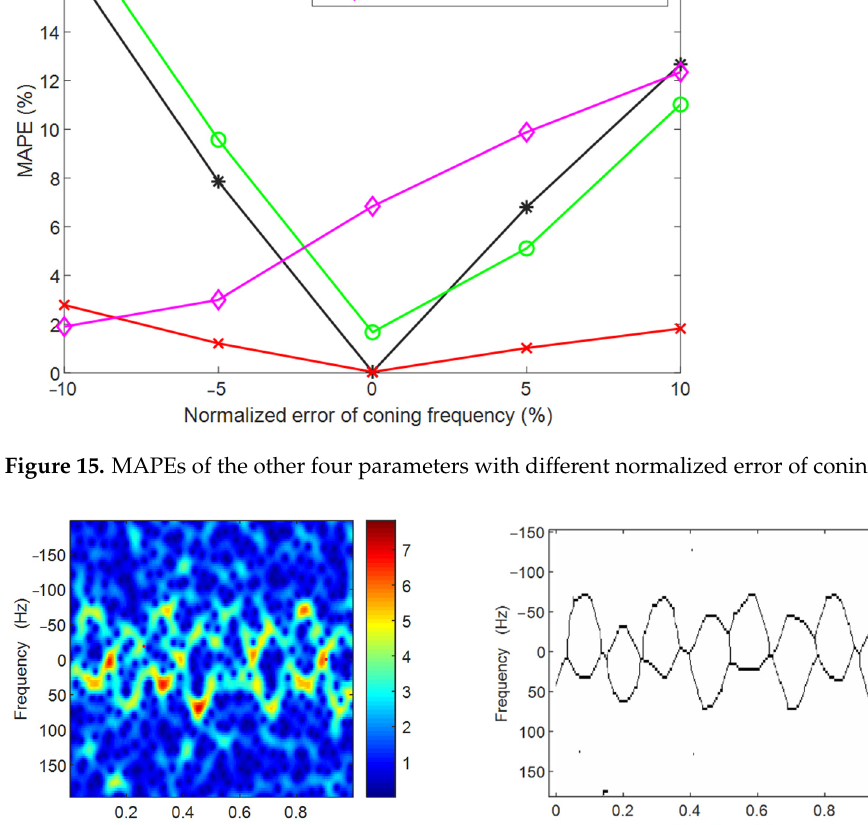
Figure 16. The echo micro-Doppler curves and skeletons when SNR is − 10 dB. ( a ) Echo micro-Doppler curves. ( b ) Skeletons of echo micro-Doppler curves.